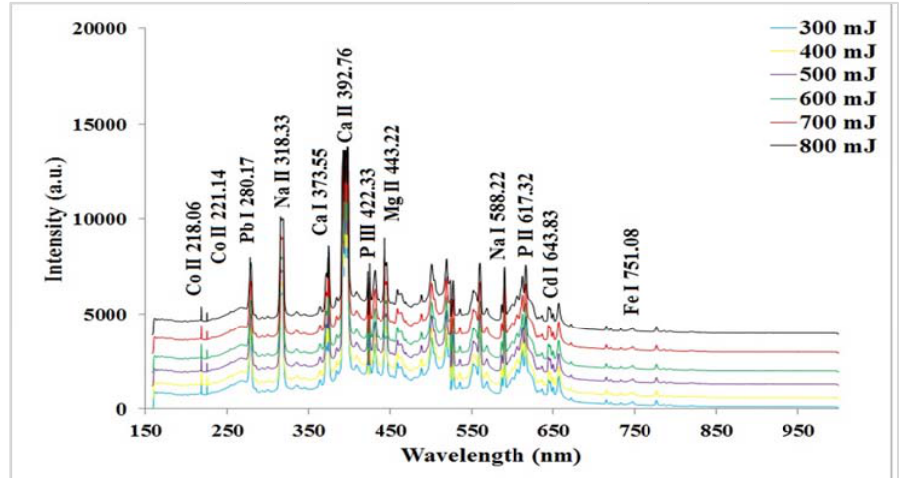
pectra of smo oker enamel l teeth for ma